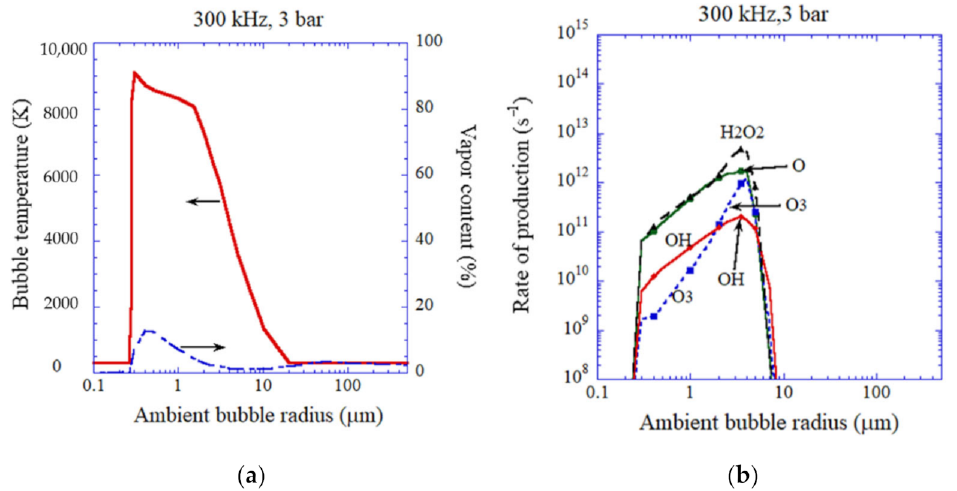
Figure 8. The results of the numerical simulations as a function of ambient bubble radius for an isolated air bubble for 300 kHz and 3 bar [59]. ( a ) The temperature inside a bubble and the molar fraction of water vapor at the violent collapse. ( b ) The rate of production of each oxidant. Copyright 2008, with permission of AIP